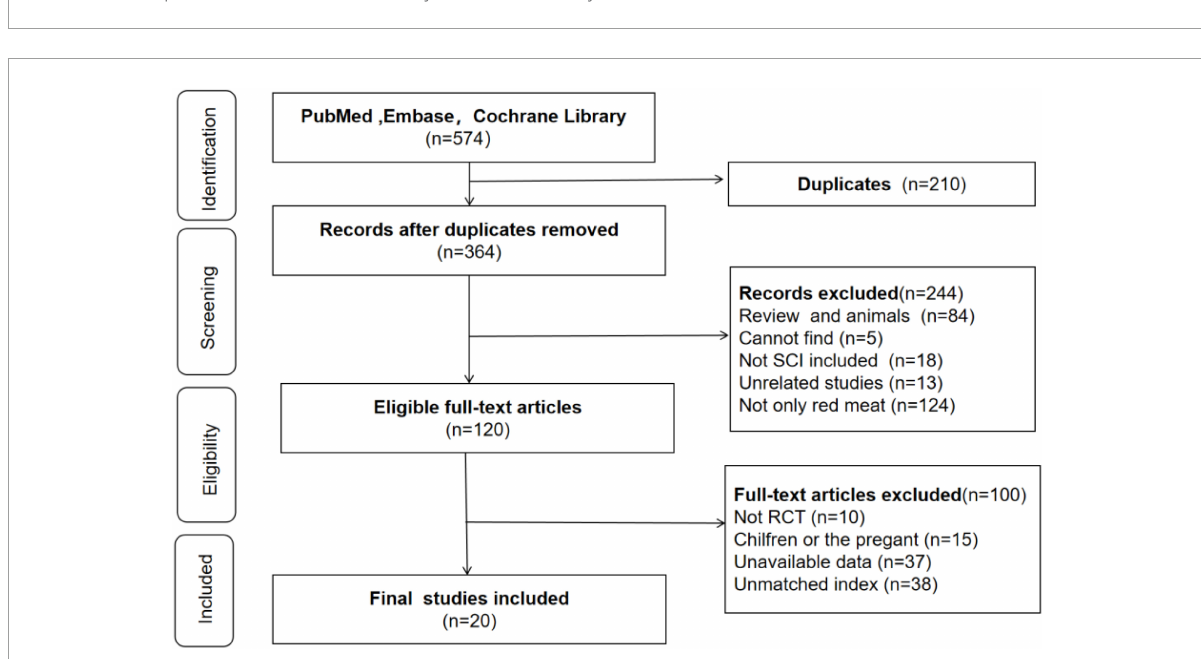
FIGURE2 Flowchart of study